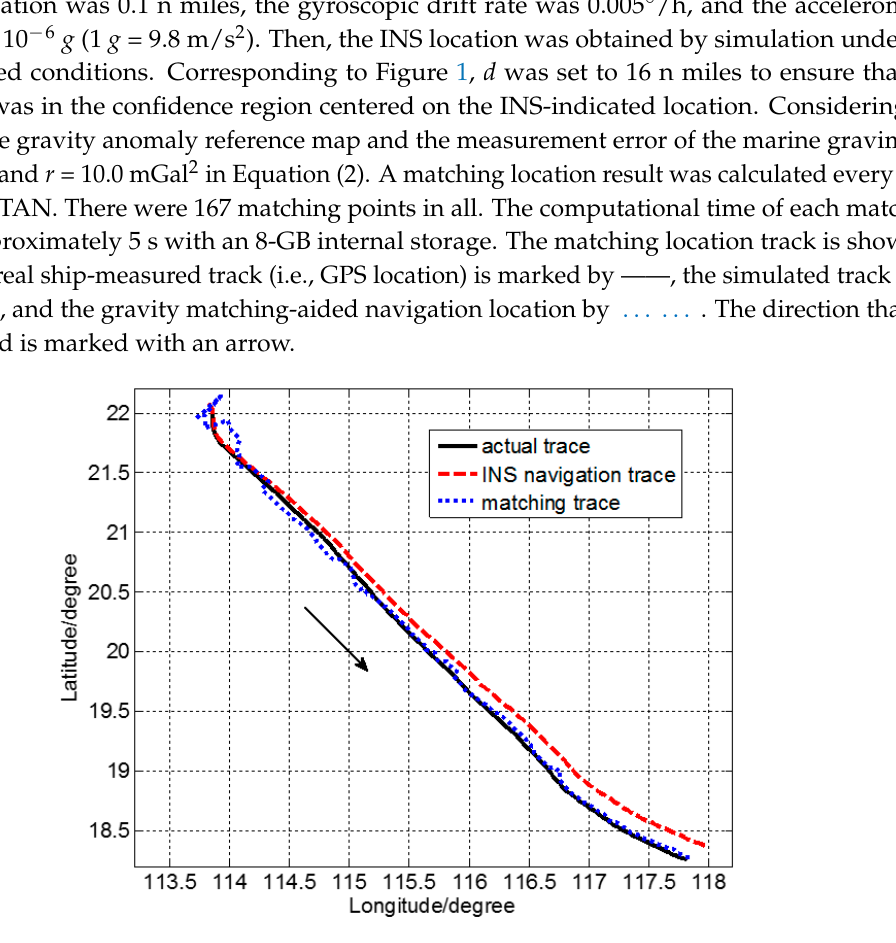
Figure 4. Matching and location trace during the ocean experiment.